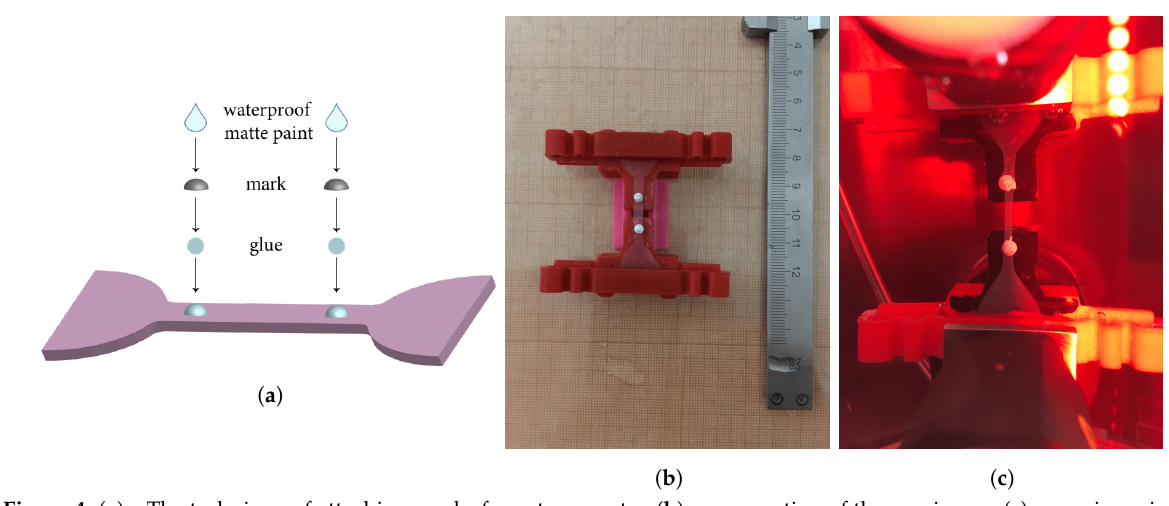
Figure 4. ( a )—The technique of attaching marks for extensometer, ( b )—preparation of the specimens, ( c )—specimen in the tensile